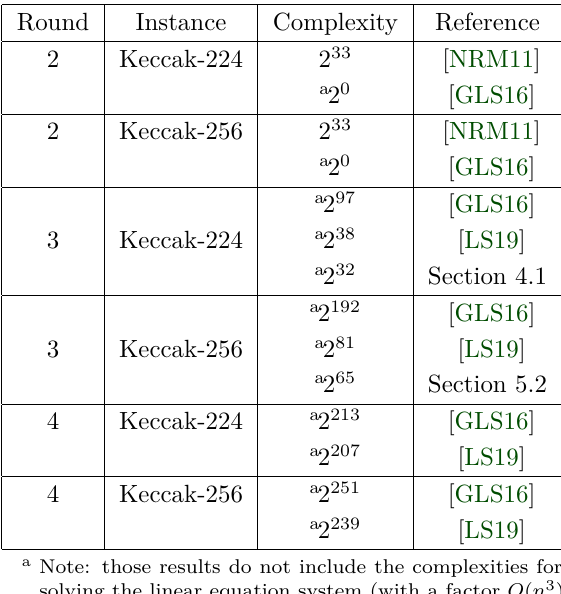
Table 1: Summary of preimage cryptanalysis on round-reduced Keccak-224/256. Round Instance Complexity Reference 2 Keccak-224 2 33 [NRM11] a 2 0 [GLS16] 2 Keccak-256 2 33